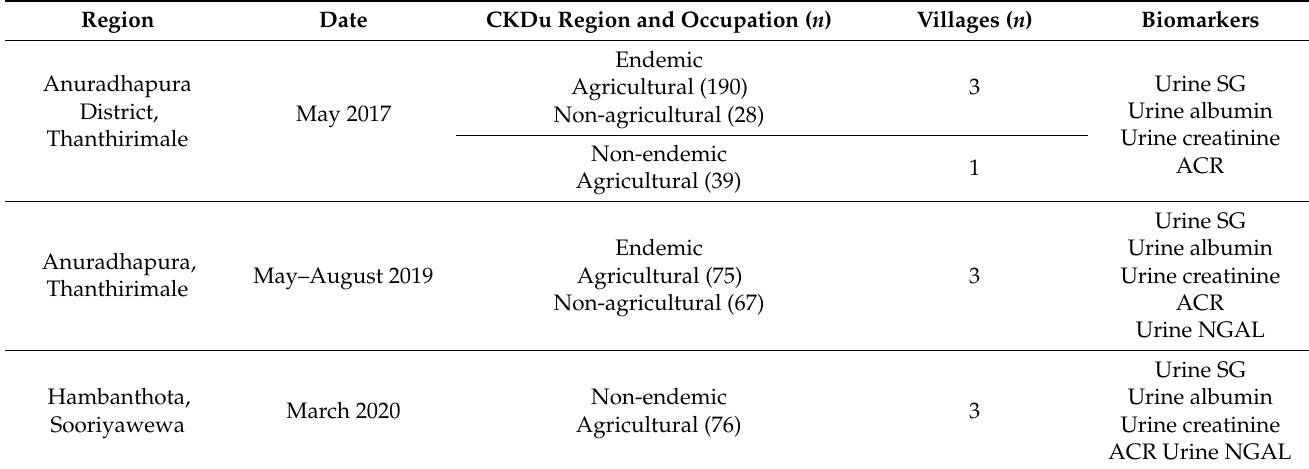
Table 1. Distribution of Sample, by Region and